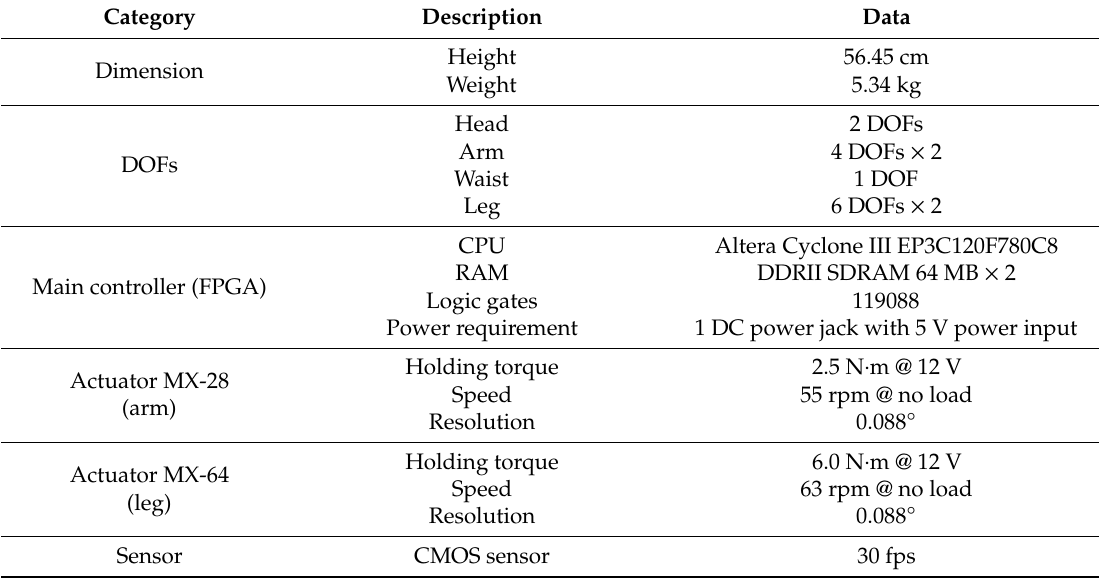
Table 1. Specifications of the small-sized humanoid robot.